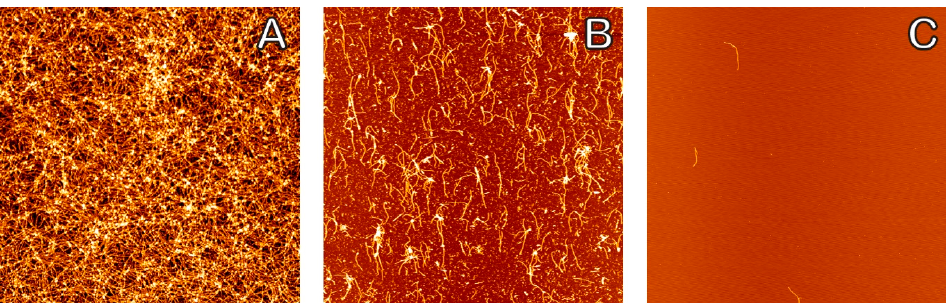
Figure 1. Effect of dilution on amyloid crowding. A comparison of AFM images of amyloid fibrils in the presence of a 100 μ M DHA sample at different dilutions, each incubated for 6 h. ( A ) 1:1 dilution showing an extreme number of surface structures and amyloid fibrils crowded together; ( B ) 1:10 dilution with a moderately uniform surface coverage of fibrils that are suitable for image analysis; and ( C ) 1:100 dilution with very few surface features and fibrils. The 1:10 dilution was chosen for further experimentation. The dimensions of each image are 10 × 10 μ m.